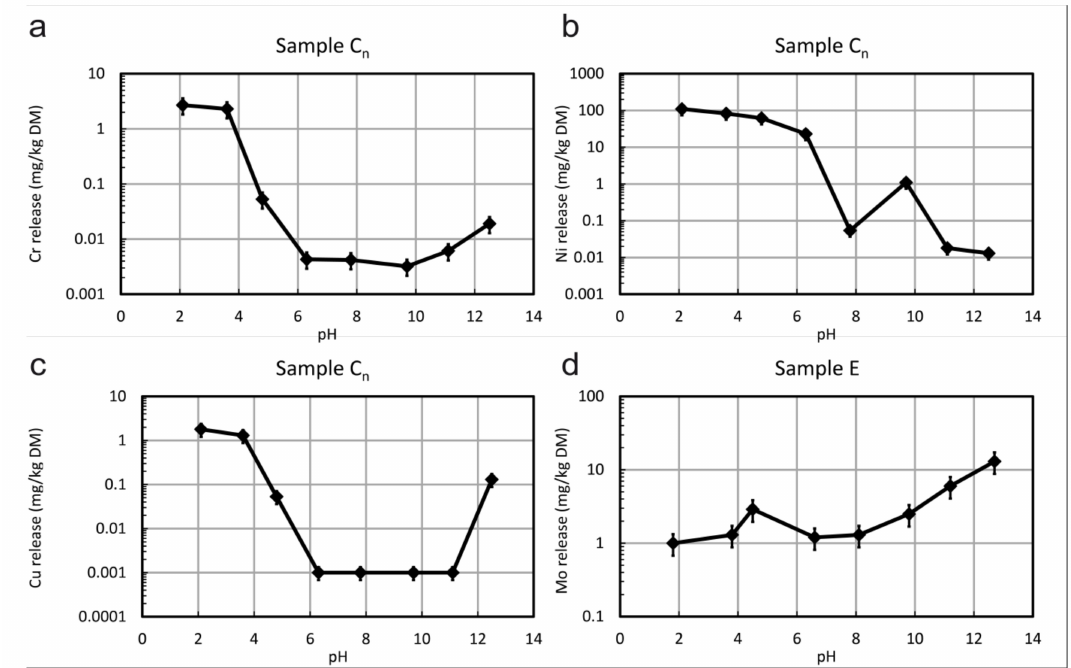
Figure 7. pH-dependent leaching of ( a ) Cr, ( b ) Ni, and ( c ) Cu from sample C n and of ( d ) Mo from sample E, values refer to the dry matter (DM) of the solid considering a liquid-to-solid ratio of